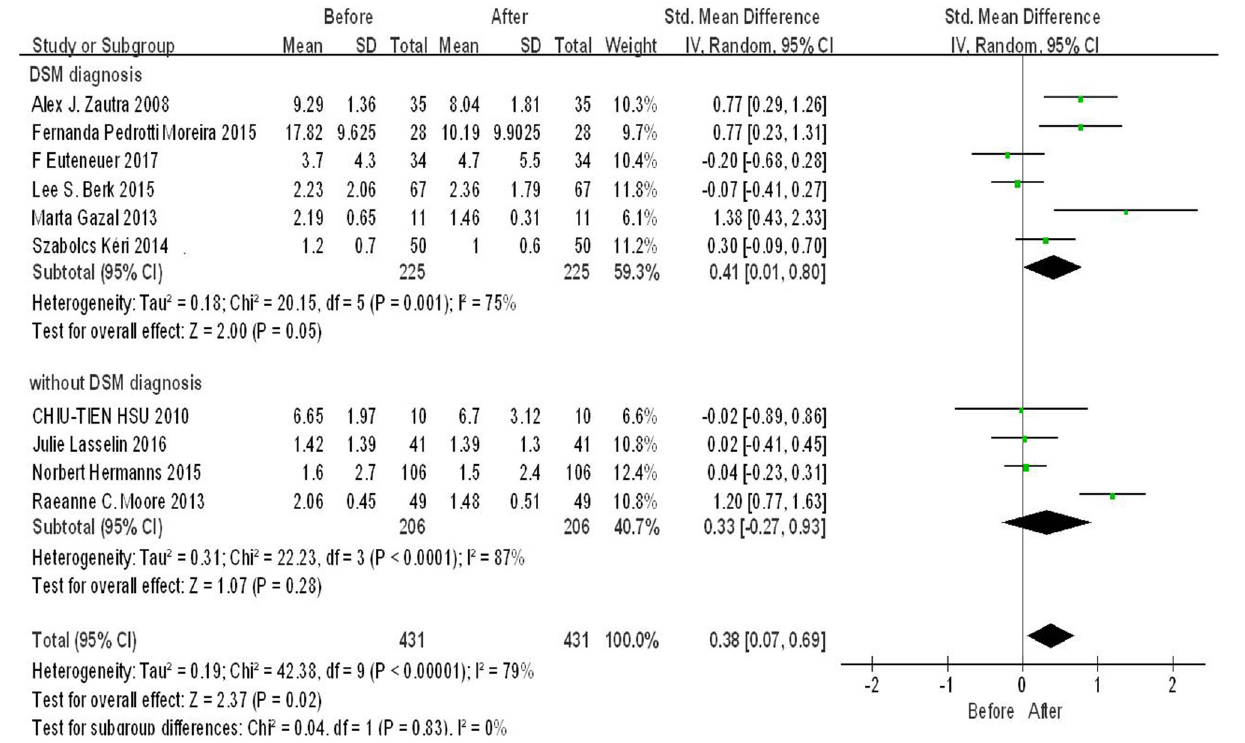
FIGURE 4 | Forest plot for change in IL-6 before and after CBT under different depression diagnosis